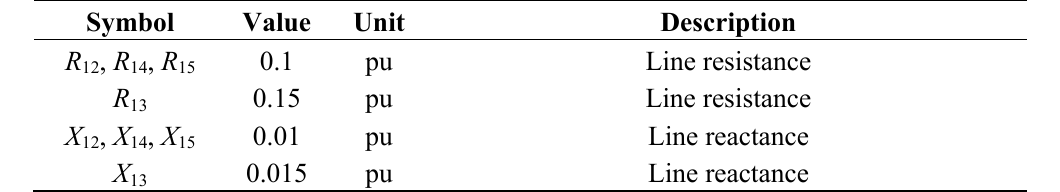
Table 1. Grid parameters.